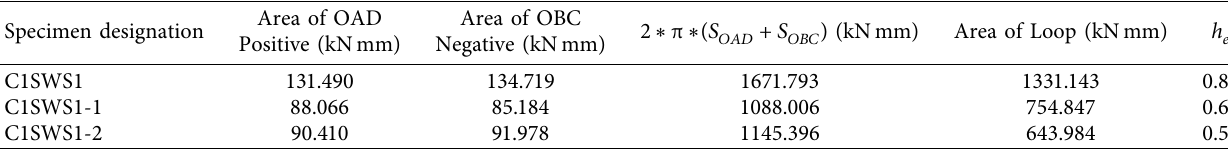
Table 9: Cumulative energy dissipation and EVD for aspect ratio of H/W